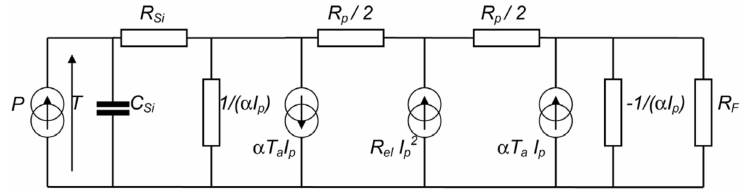
Figure 5. Simplified equivalent network.